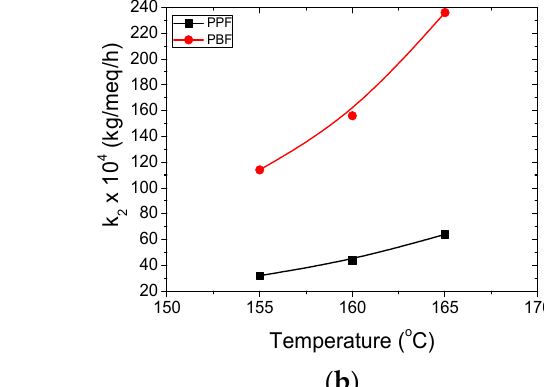
Table 2. Kinetic rate constants of the polycondensation / transesterification (k 1 ) and esterification (k 2 ) reactions and concentration of temporarily inactivated OH and COOH end-groups at di ff erent reaction temperatures for PPF and PBF polyesters.